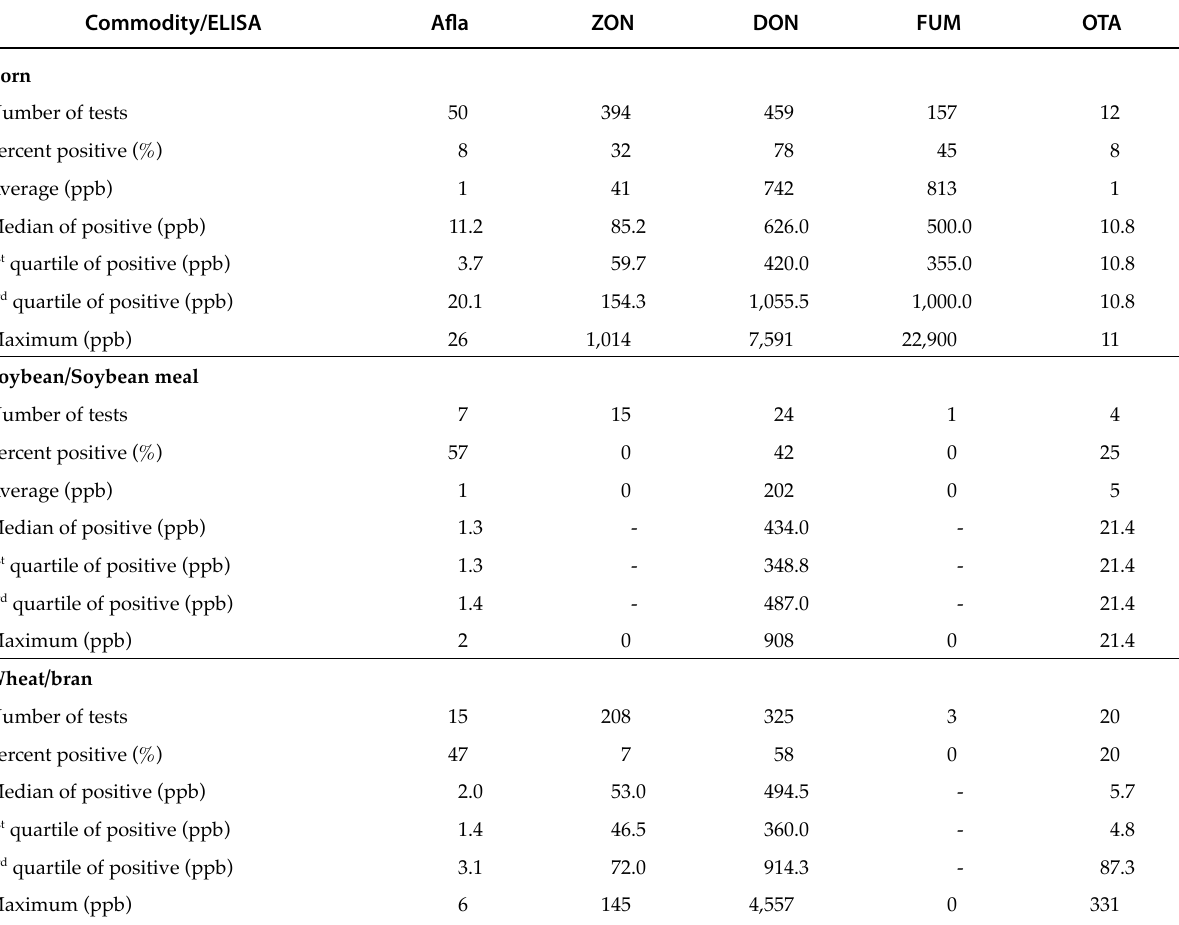
Table 7a. Survey results by commodity, determined by